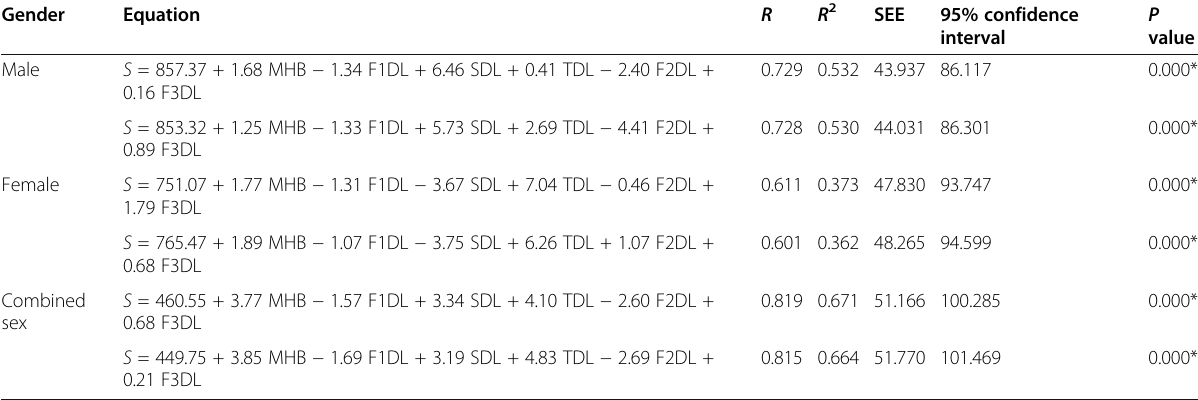
Table 4 Multiple regression equations to estimate the stature from handprint measurements (in mm)